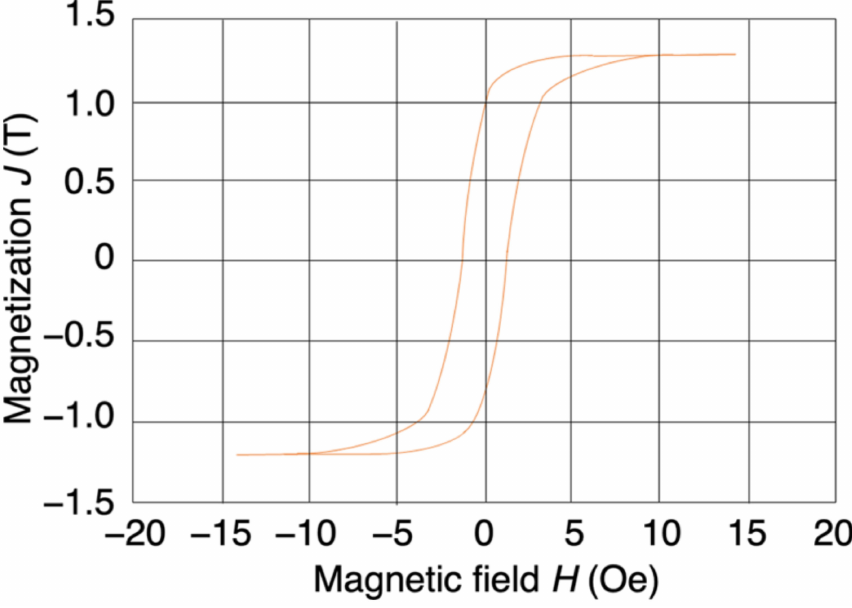
Figure 1. Hysteresis loop of a Co–Fe–Si–B amorphous magnetic wire with a diameter of 10 µ